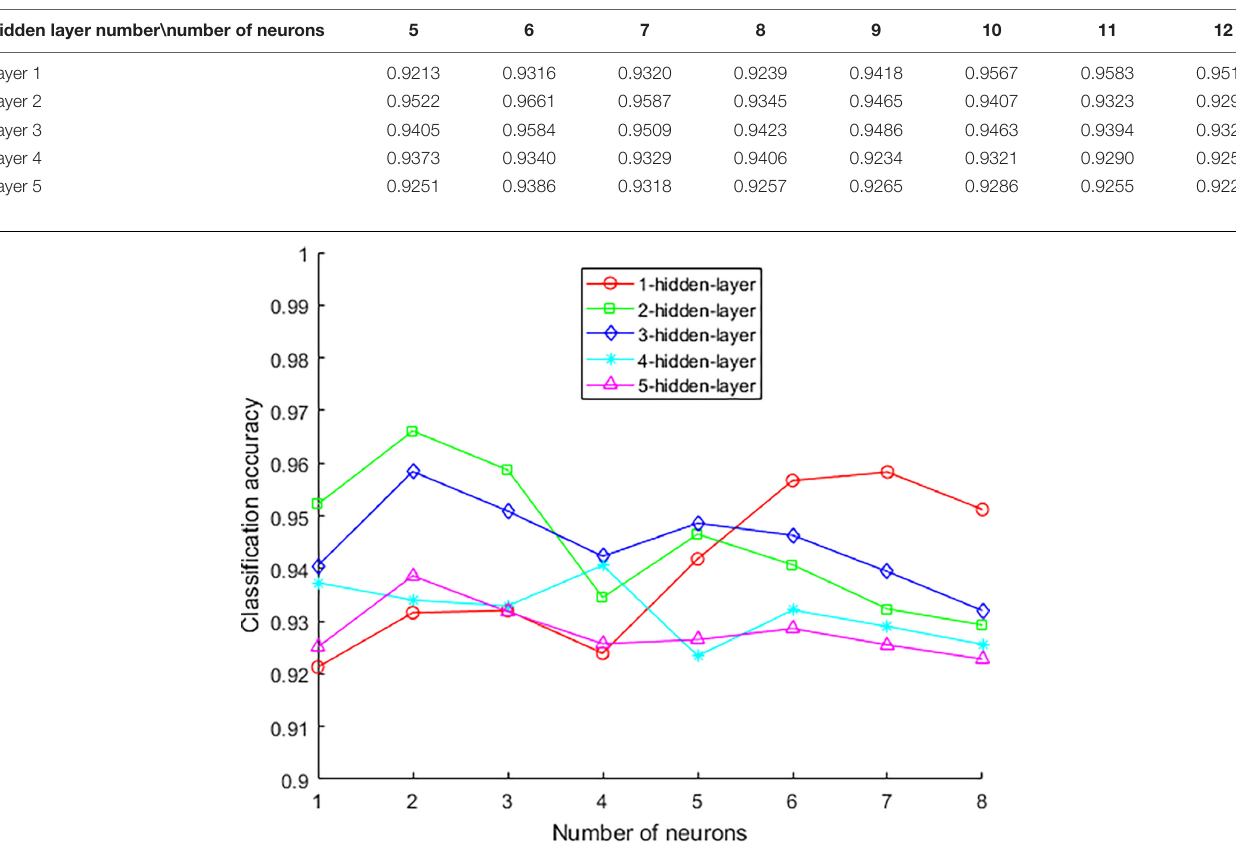
TABLE 2 | Classification accuracy of different numbers of neurons in each layer. Hidden layer number\number of neurons